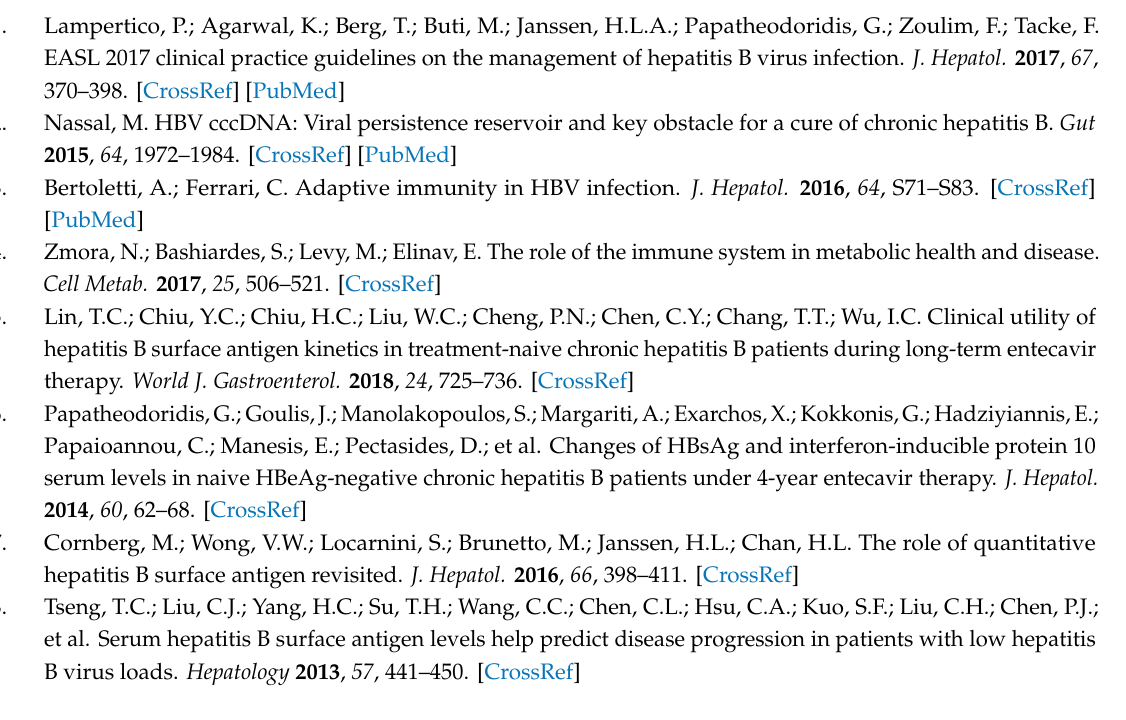
Table S1: Terms and definitions, Table S2: Clinical events occurred during long-term entecavir therapy, Table S3: Bivariate linear mixed e ff ect models for predicting HBsAg during the 2nd to 10th years, with regard to each variable and their interaction with time. Table S4: Levels of the di ff erent cytokines / chemokines in this study and other clinical scenarios, including healthy controls, diabetic patients, and patients with sepsis. Figure S1: Comparison of IP-10 levels between the groups categorized by with or without prediabetes or T2DM. Figure S2: A theoretical hypothesis of two